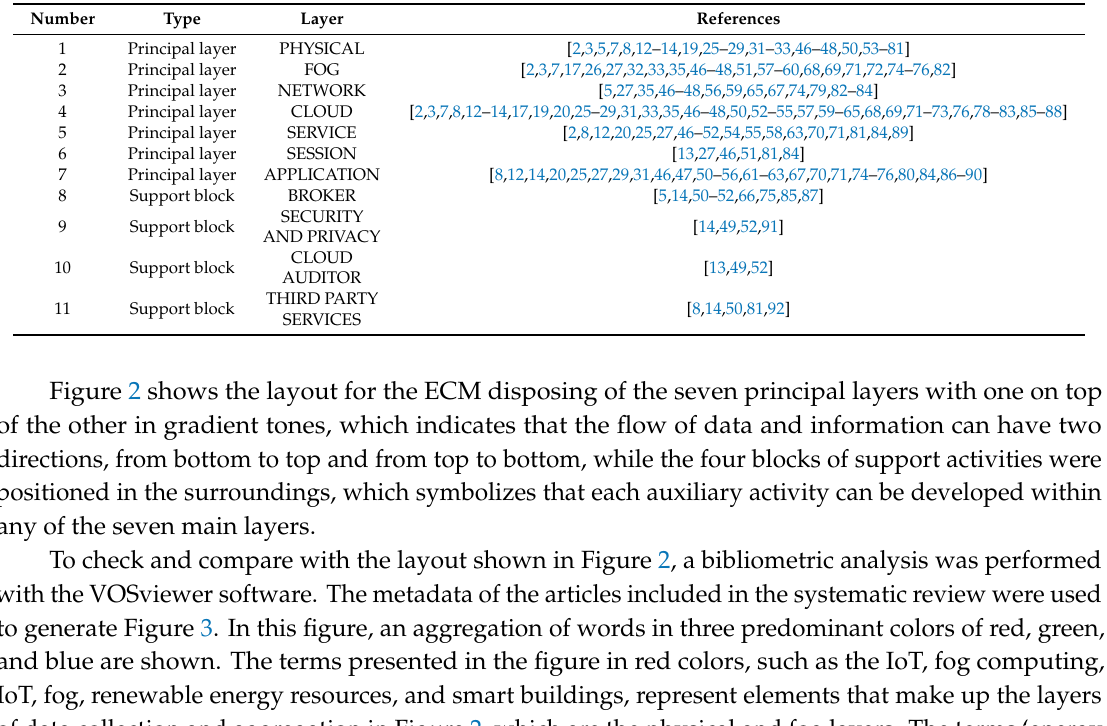
Table 4. References on layers and support block for energy cloud management